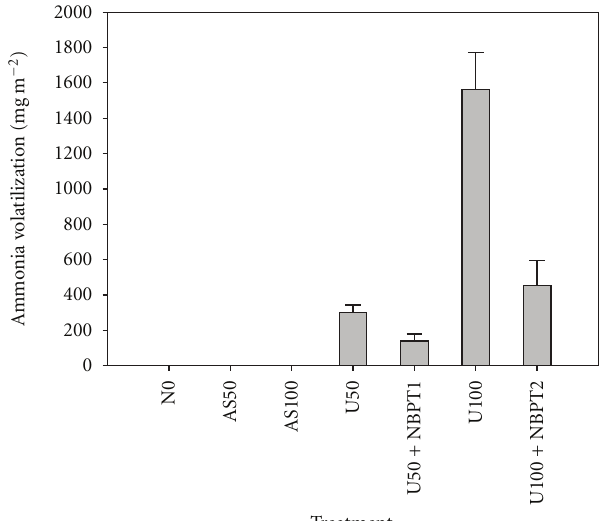
Figure 1: Ammonia volatilization under application of AS50 (ammonium sulfate, 50 kgN ha − 1 ), AS100 (ammonium sulfate, 100 kgNha − 1 ), Urea50 (50kg Nha − 1 ), Urea100 (100kg Nha − 1 ), Urea50 + NBPT1 (50kgN ha − 1 + 1.09kg NBPTha − 1 ), and Urea100 + NBPT2 (100kg Nha − 1 + 2.18 kg NBPTha − 1 ) in compar- ison with zero N input (control) in a field experiment. Ammonia volatilization was the sum of ammonia volatilized during 14 days after sowing. Error bars represent the standard